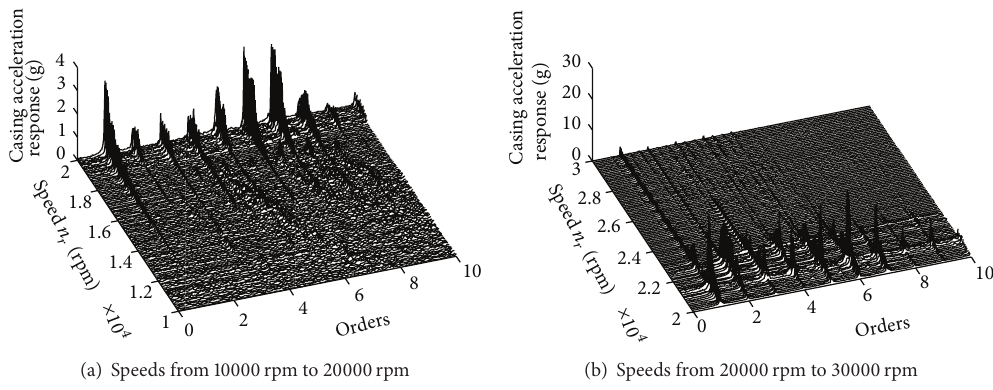
Figure 16: Cascade plot of the casing acceleration response at different